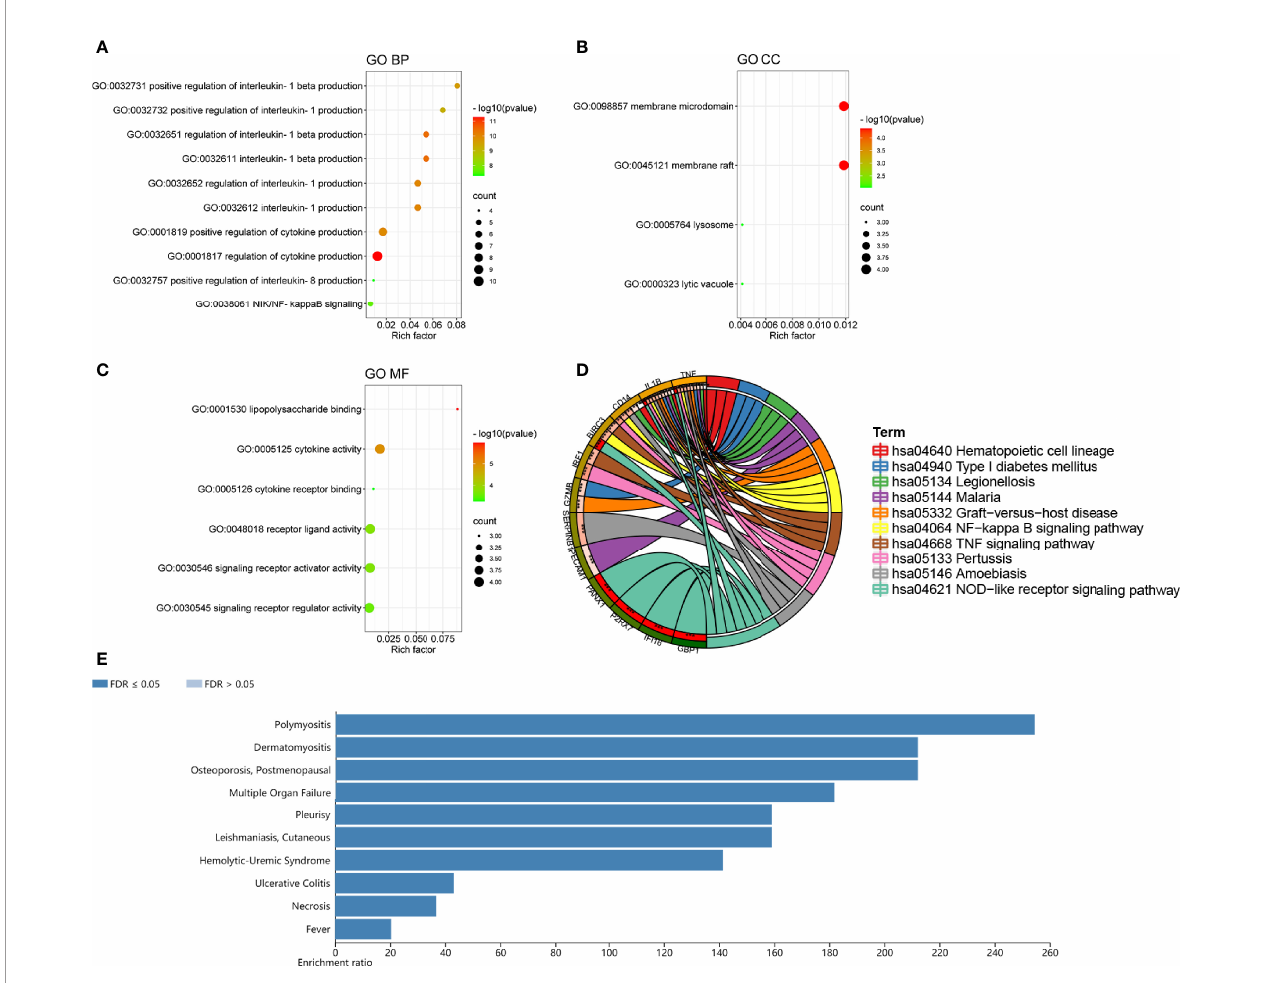
FIGURE 3 | The top ten lists of function enrichment analyses of DEPRGs. (A) GO BP; (B) GO CC; (C) GO MF; (D) KEGG signaling pathway; (E) DO enrichment. **p < 0.01; ***p <